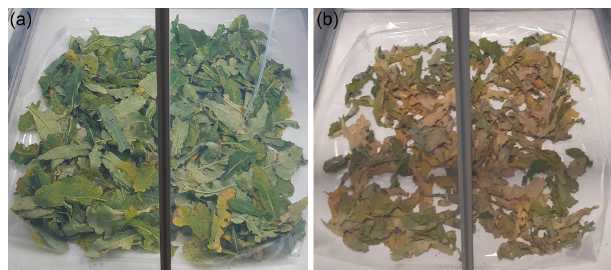
Figure 1. Example of the rapeseed litter condition (a) during the first day of the VOC and particle measurements and (b) after 6d of VOC and particle